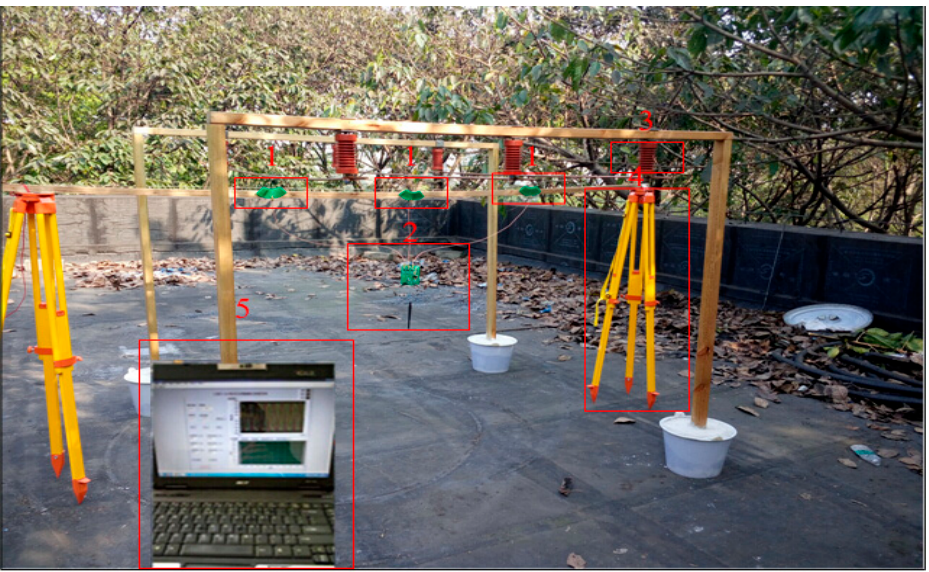
Figure 7. Sketch map of measuring three-phase voltage.